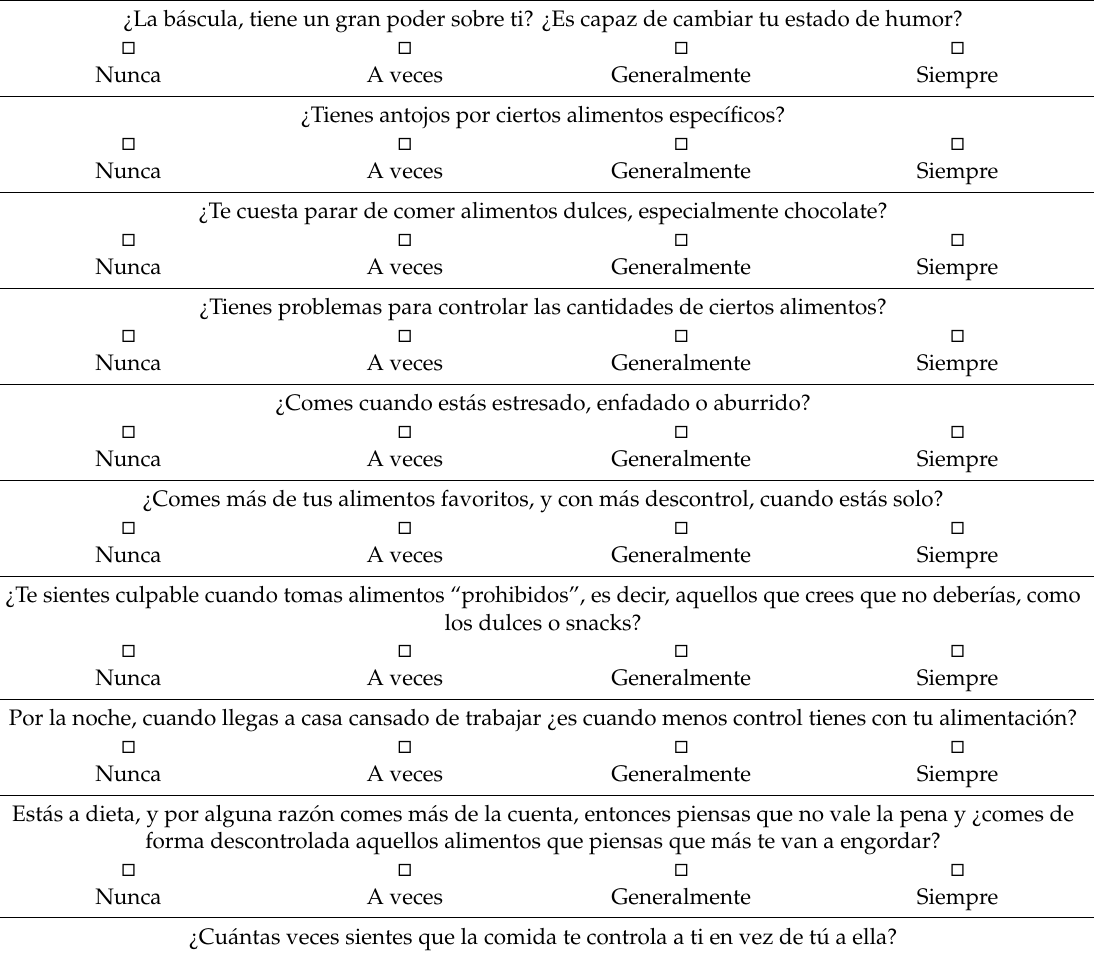
Table A1. Cuestionario del Comerdor Emocional Garaulet